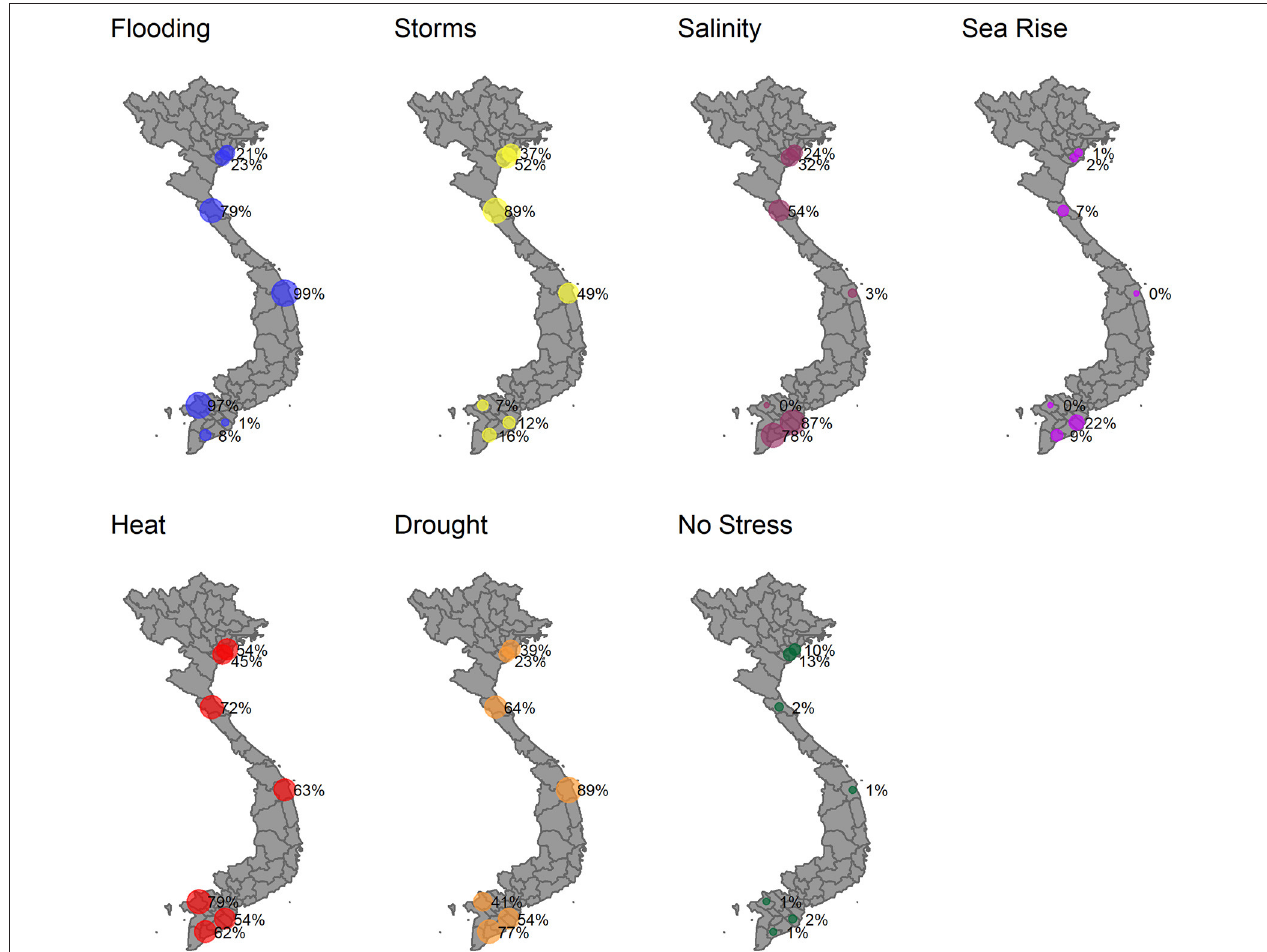
FIGURE 1 | Prevalence of climatic stresses, by